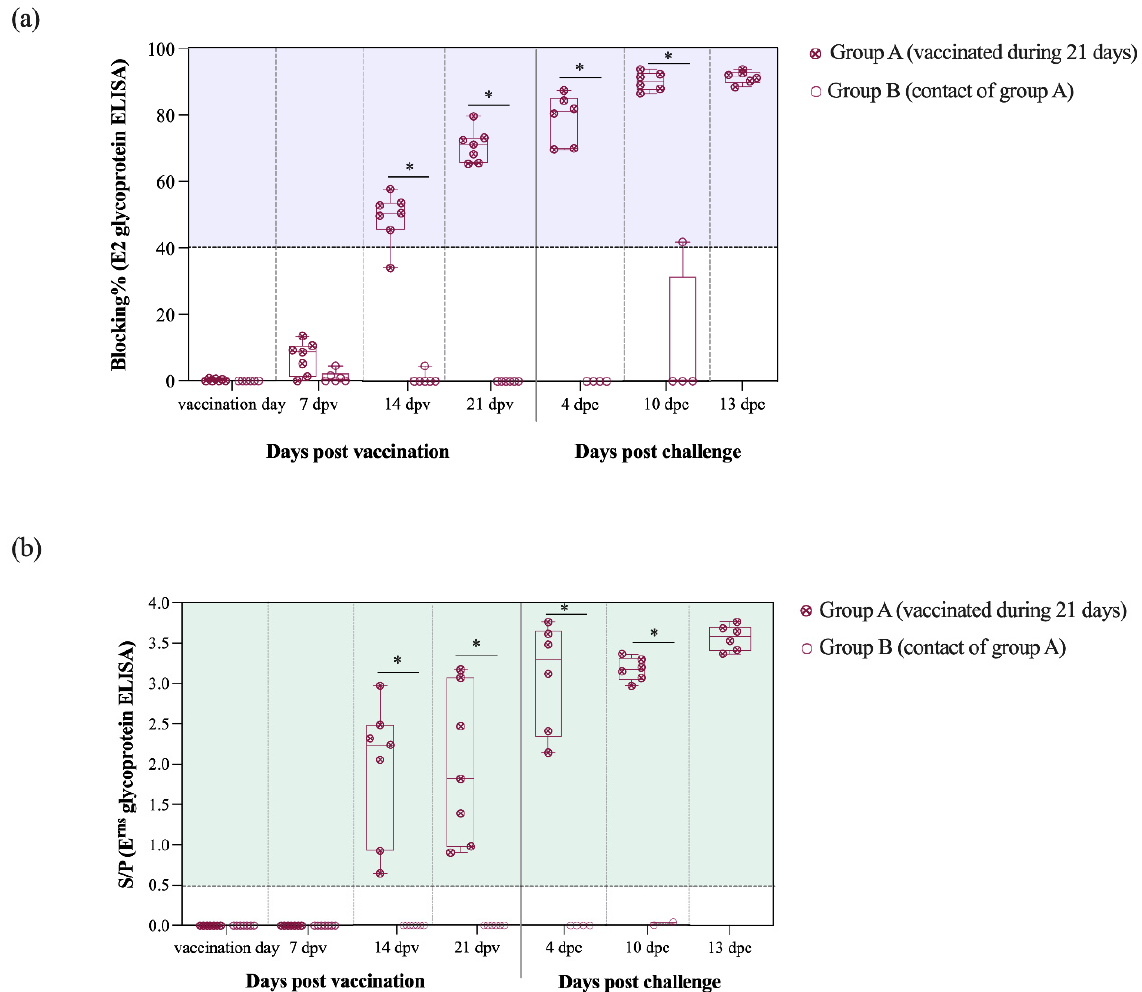
Figure 4. Kinetic of E2 and E rns antibody response generated after vaccination and challenge for groups A and B. ( a ) Antibody response against the E2 glycoprotein was detected and is represented as blocking percentage. ( b ) Antibody response against E rns was detected by ELISA and reported as the S/P value in accordance with the formula previously described. Statistically significant differences between the groups A and B in the antibody response against E2 ( a ) and E rns ( b ) glycoproteins are represented by the asterisk symbol: (*) indicates p < 0.05.